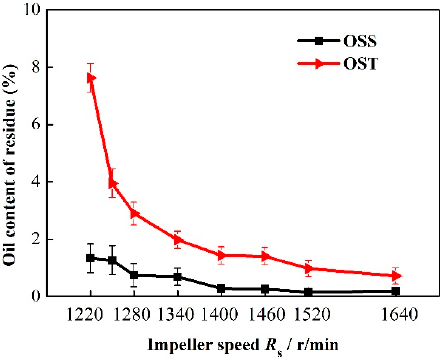
Figure 5. Influence of impeller speed on the oil content of residue. Flotation conditions: C c = 400 mg/L, T t = 25 min, T p = 33 °C, L/OS =